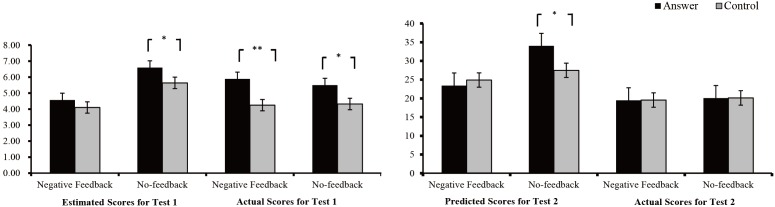
Comparison between the two groups across conditions. ∗p < 0.05, ∗∗p < 0.01, ∗∗∗p < 0.001.